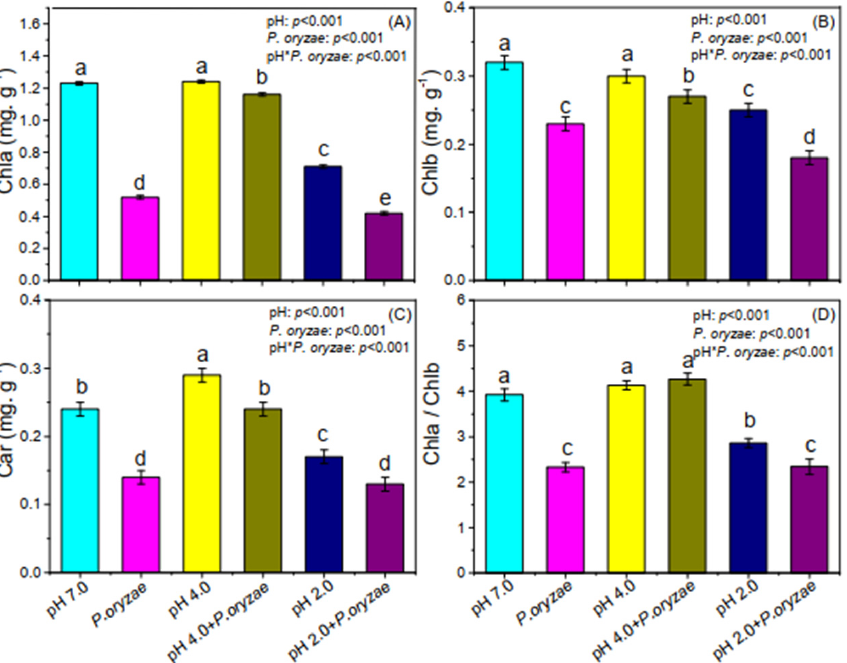
Figure 2. Photosynthetic pigment contents in rice seedlings under SAR and P. oryza treatment. Chlorophyll a (Chla, A ), Chlorophyll b (Chlb, B ), Cartenoid (Car, C ), and ratio of Chlorophyll a to Chlorophyll b (Chla/Chlb, D ) in rice seedlings. Different lowercase letters indicate significant different between groups ( p < 0.05). Values are the average ± standard error ( n = 9).